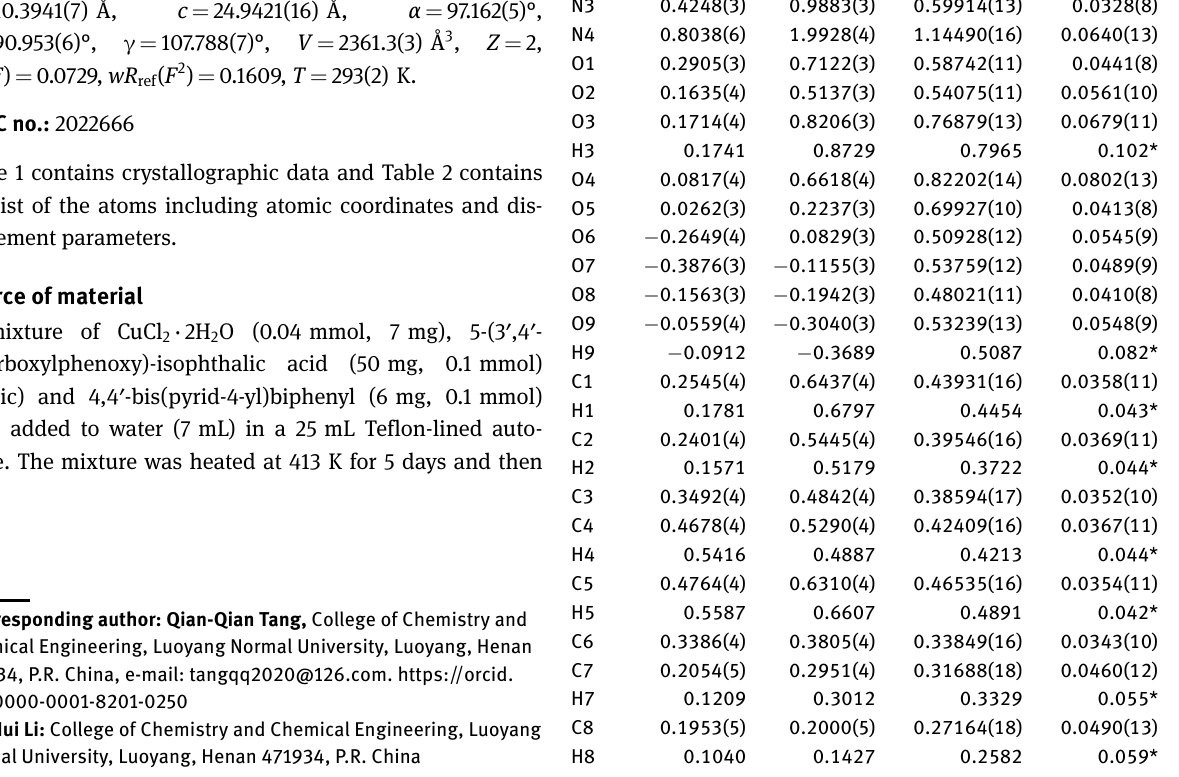
Table 1 contains crystallographic data and Table 2 contains the list of the atoms including atomic coordinates and dis- placement parameters.